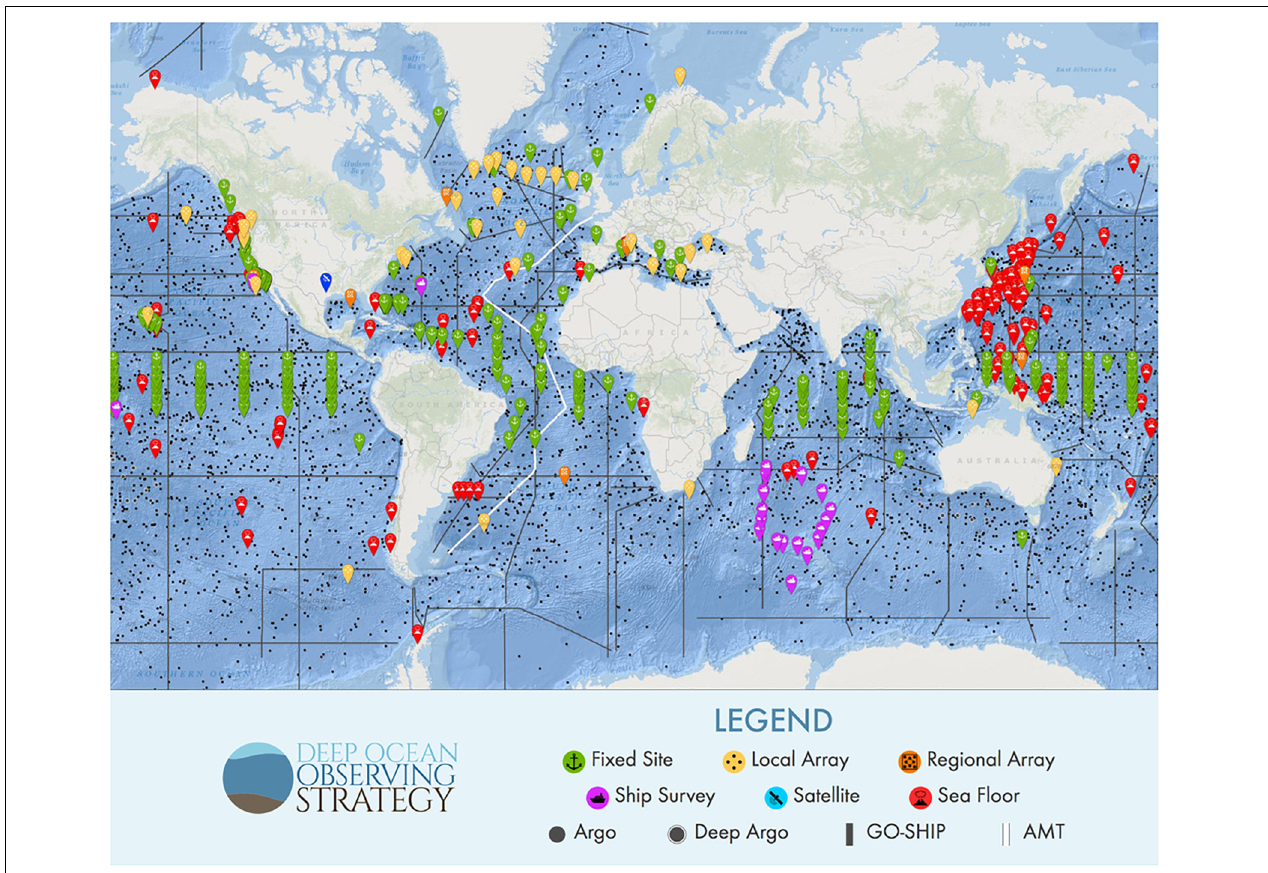
FIGURE 1 | Inventory of sustained deep-ocean observing (Interactive map available online, http://www.deepoceanobserving.org/observations/deep-ocean-